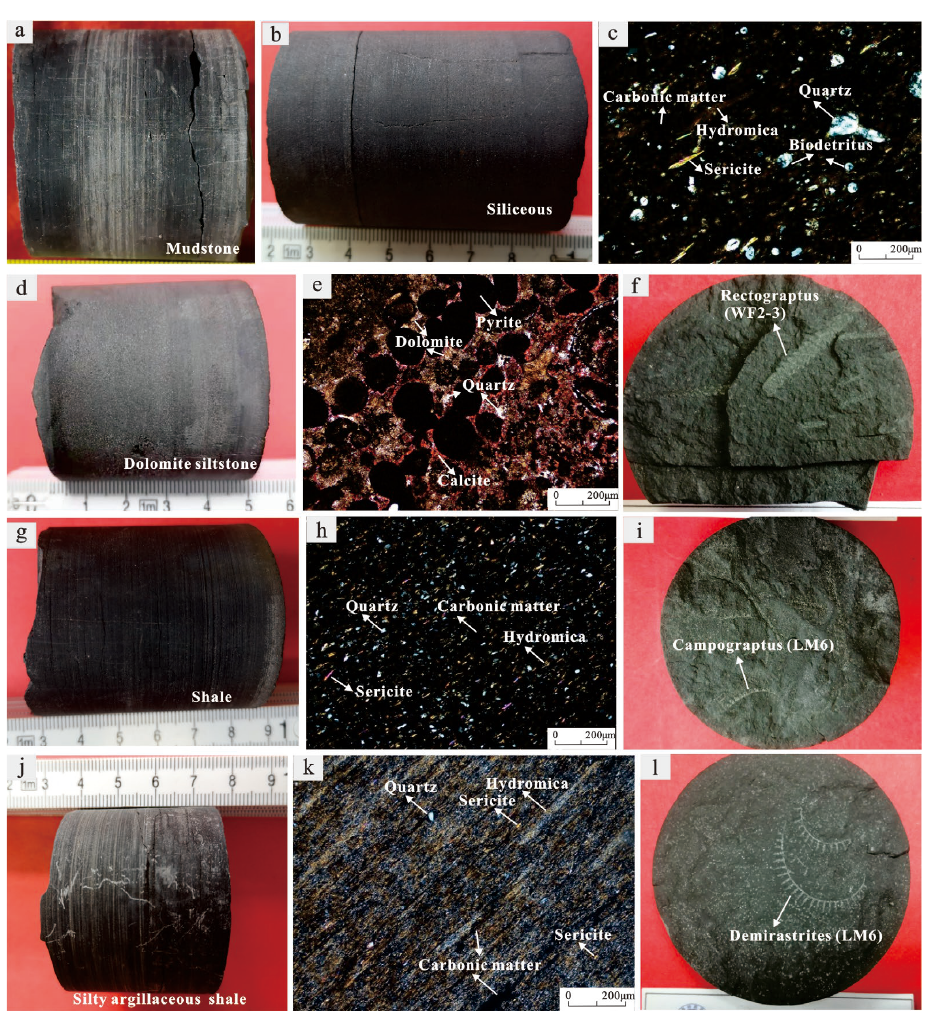
Figure 2. ( a ) Core image of dark grey carbonaceous mudstone in the LX, sample Y1 with a depth of 625 m. ( b , c ) Core and thin section images of black carbonaceous siliceous rock in the WF, sample Y9 with a depth of 618.46 m. ( d , e ) Core and thin section images of grey - black carbonaceous dolomite siltstone in the WF, sample Y8 with a depth of 619.5 m. ( f ) Rectograptus image of graptolite biozones WF2 - 3 in the WF, depth 621.26 m. ( g , h ) Core and thin section images of black carbonaceous shale in the LLM, sample Y13 with a depth of 616.1 m. ( i ) Campograptus image of graptolite biozone LM6